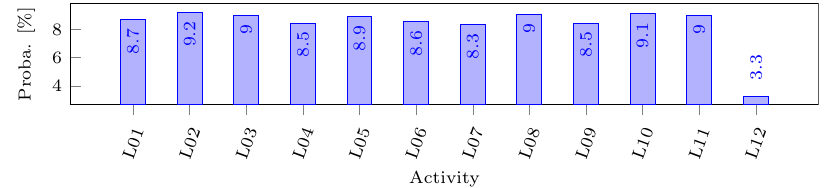
Figure 1. Probability distribution of classifying human activities in the MHEALTH.